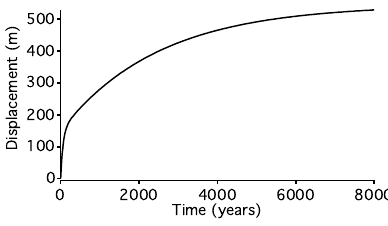
Figure 12. Horizontal displacement of a hypothetical glacier layer sinking from the surface to bedrock according to the vertical dy- namic that follows the empirical age–depth relationship developed in this